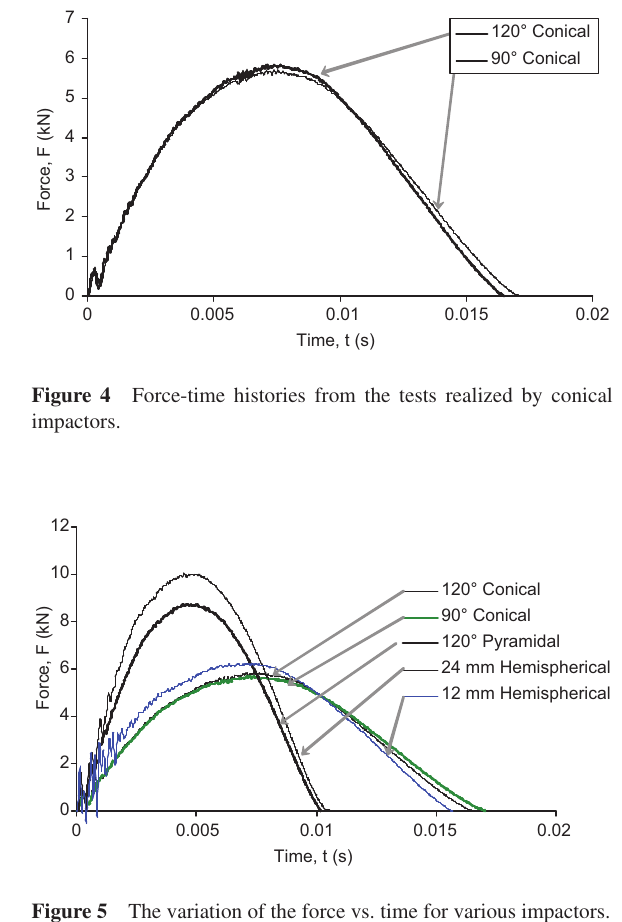
Figure 5 The variation of the force vs. time for various impactors.